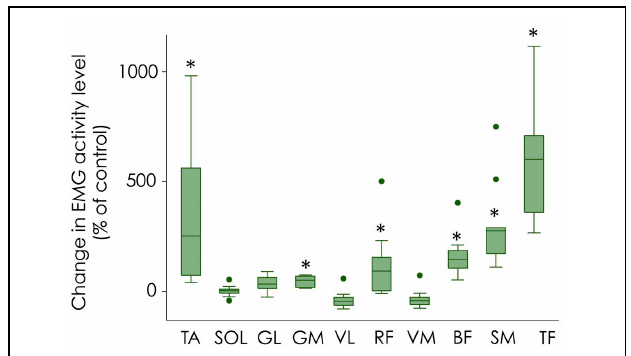
FIGURE 3 | Change in muscle activity level (mean value over the crank cycle). Changes in EMG amplitude normalized to the control condition are shown with box plots for each muscle. Error bars denote the 95% confidence interval; box denotes the 25–75 percentile with the median. Dots corresponds to the outliers for muscle abbreviations see Figure 2 . ∗ Significantly different from control.